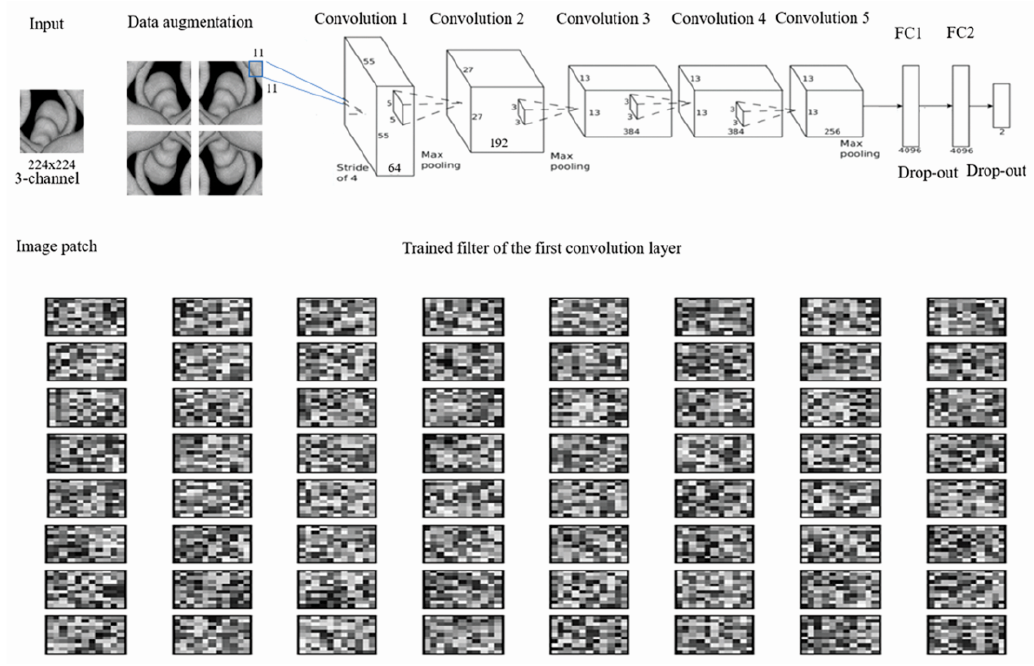
Figure 2. The proposed convolutional neural network consisting of convolutional layers, max-pooling layers, fully-connected layers, drop-out layers, and final layers of classification. The number of filters, the connections in each layer, and the first layer of the learned convolutional kernel are described above. FC, fully-connected.